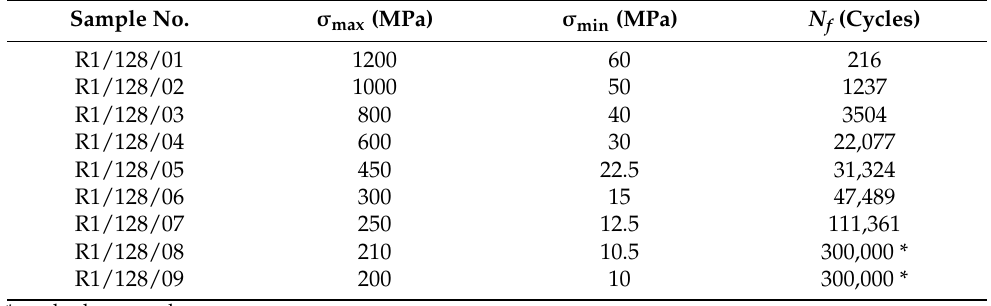
Table 3. Tensile fatigue test results.